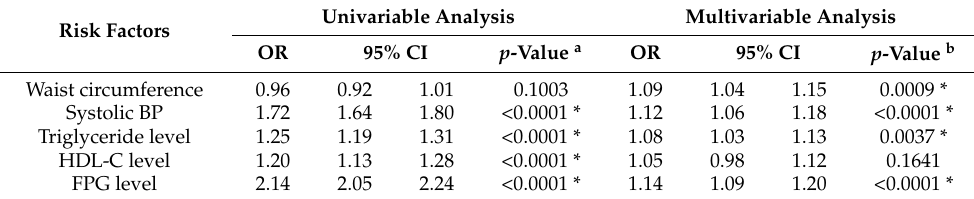
Table 6. Association between hearing loss and metabolic